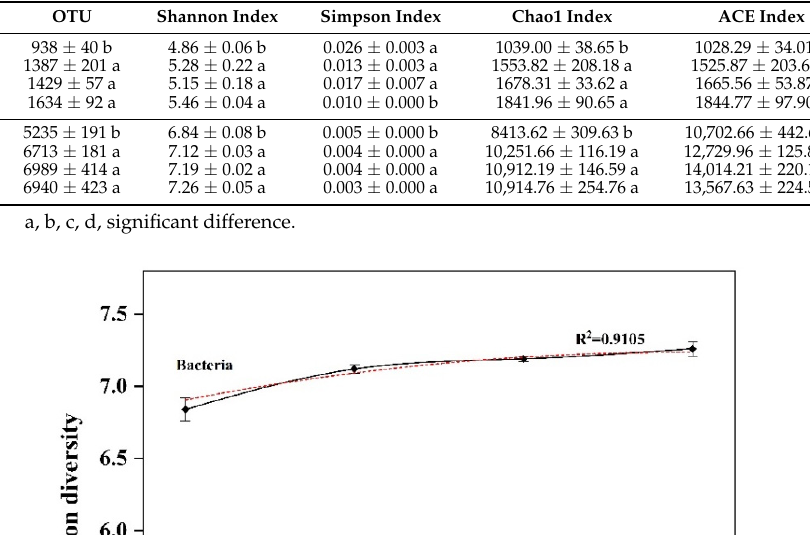
Table 3. Alpha diversity of rhizosphere soil microorganisms.